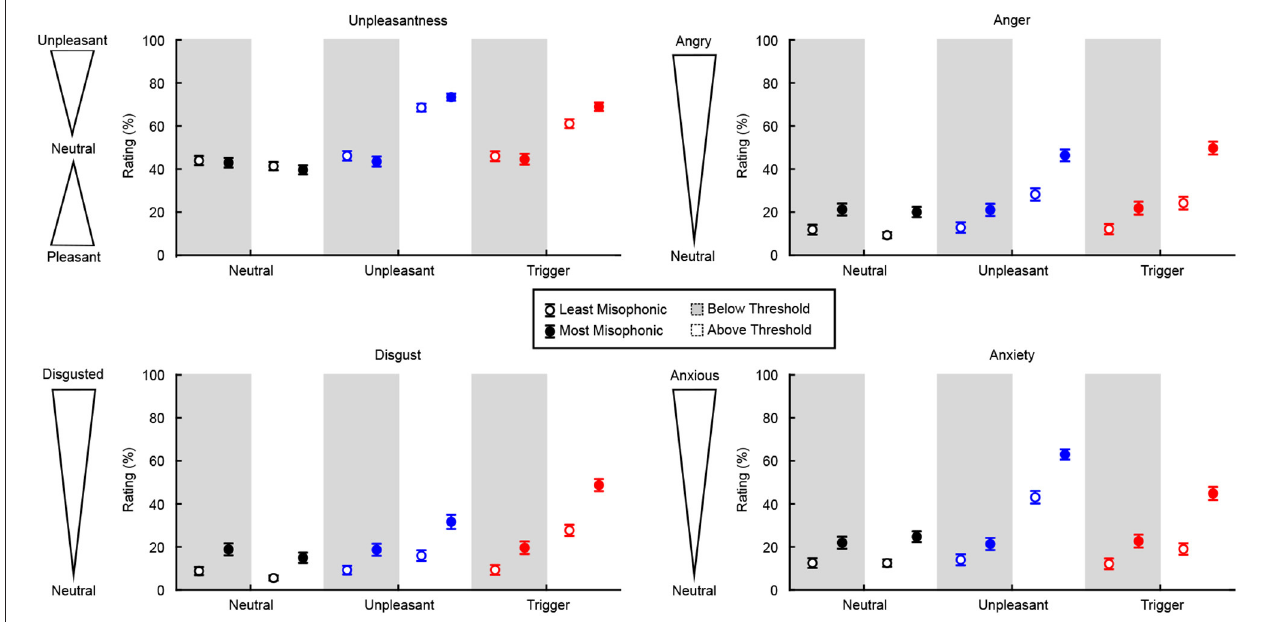
FIGURE 5 | Change in subjective ratings below and above identification thresholds, for each group and sound category. Unpleasantness ratings are from 0 (pleasant) to 100 (unpleasant), with 50 being a neutral rating. For Anger, Disgust, and Anxiety, ratings are from 0 (neutral) to 100. Error bars represent ± 1 standard